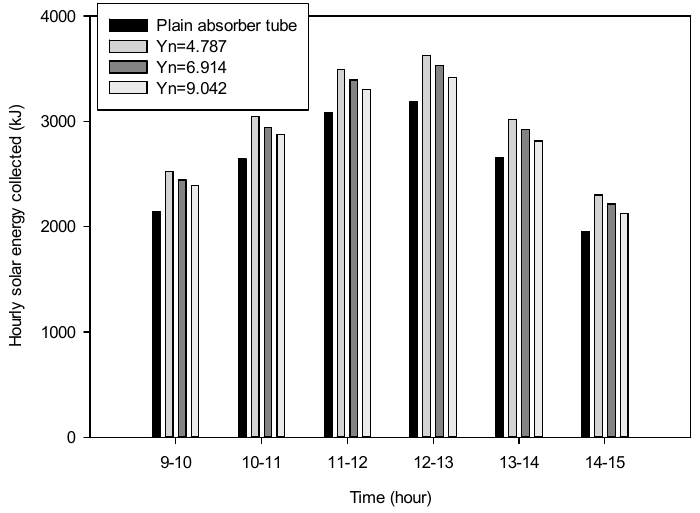
Figure 9. Variation in hourly solar energy collected with time and nail twist pitch ratio.